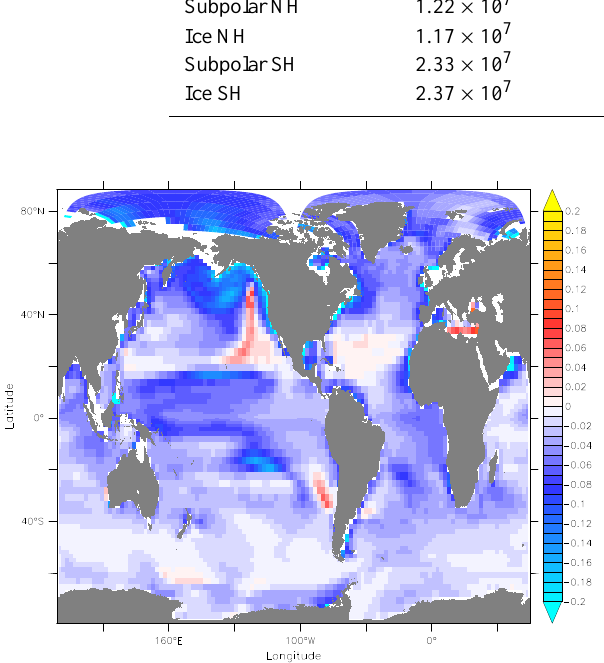
Figure 12. Biomes as defined by Sarmiento et al. (2004) applied to GFDL CM2Mc with chl&CDM k d parameterization, Eq. (5). Leg- end abbreviations: ice is marginal ice zone, SP is subpolar, LL is lower latitude, SS is seasonally stratified, PS is permanently strat- ified, EQ DW is equatorial downwelling, EQ UP is equatorial up- welling. Suffixes NH and SH stand for Northern Hemisphere and Southern